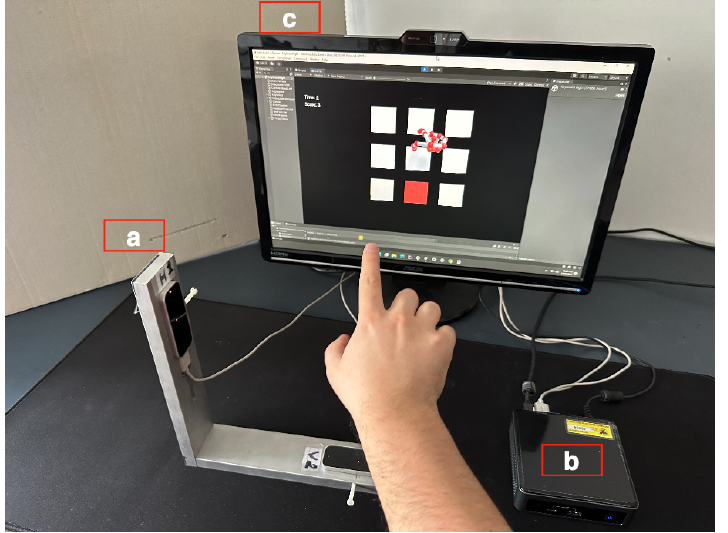
Figure 2. VG final implementation, including sensor assembly ( a ), an NUC-based driving unit ( b ), and a video screen for the active interaction ( c